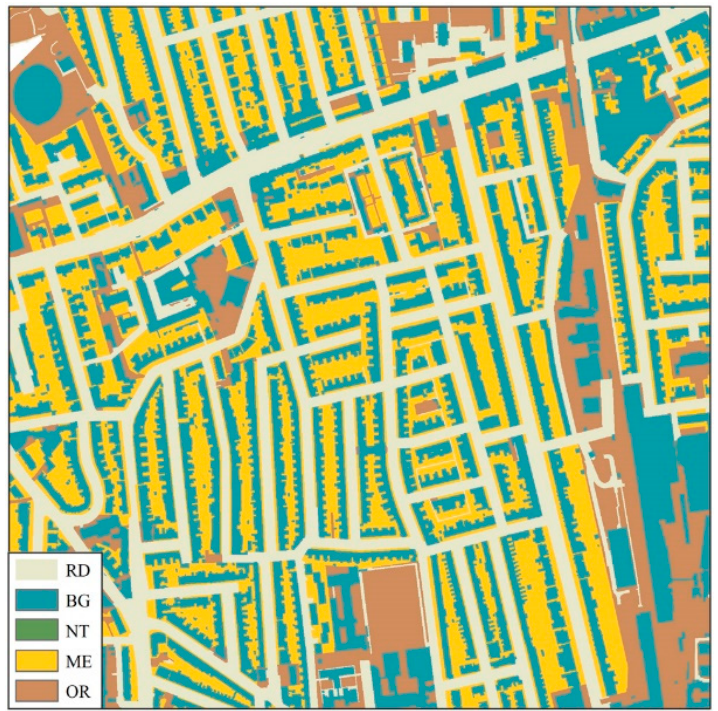
Figure 8. Different land covers in a sample area inside the reconstruction site. Figure 8. Di ff erent land covers in a sample area inside the reconstruction